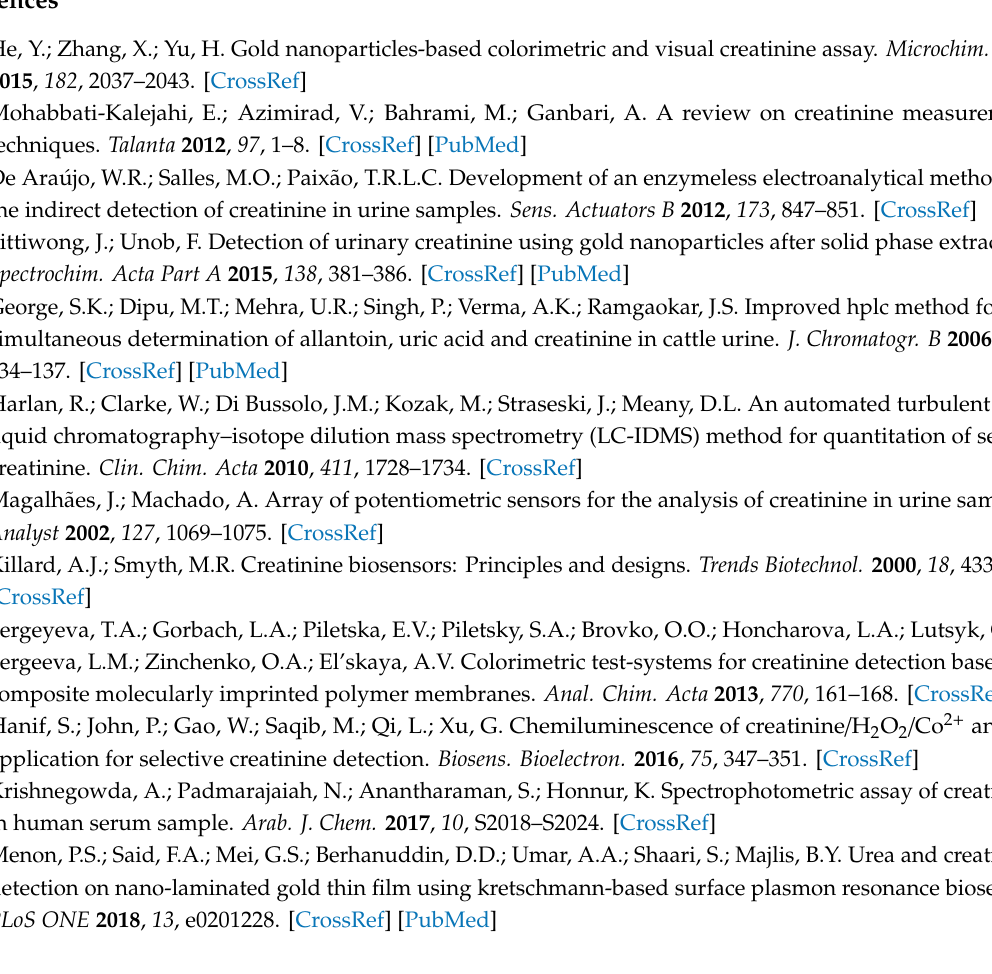
Figure S1: The stability of the PEG / Hg2 + –AuNP probe: Photographs and UV–Vis absorption spectra of the above sensor after being placed for 72 h, Figure S2: DLS diagram of images of PEG / Hg2 + –AuNPs system in the (a) absence and (b) presence of creatinine, Figure S3: XPS spectra of PEG / Hg2 + –AuNPs in the presence of creatinine with binding energies for (a) N1s, and (b) Hg4f, Figure S4: The role of Hg2 + : Absorption spectra of samples using di ff erent kinds to replace Hg2 + , Figure S5: Sensitivity of the AuNP probe (0.798 nM) in urine simulating fluid sample: (A) Photographs and (B) absorption spectra of serum samples containing di ff erent concentration of creatinine (from 20 to 120 µ M), inset: (C) linear relationship between creatinine concentration and absorbance response di ff erence in urine simulating fluid sample, Figure S6: Practicability of AuNPs probe (0.798 nM) in real bovine serum samples: (A) Photographs and (B) absorption spectra of real bovine serum sample containing di ff erent concentrations of creatinine (from 20 to 50 µ M), inset: linear relationship between creatinine concentration and absorbance response in bovine sample, Figure S7: Linear relationship of creatinine content with A500 nm values by Ja ff e’s method for bovine serum sample, Table S1: The comparison of TEM and DLS data before and after detection, Table S2: Atomic content of PEG / Hg2 + –AuNPs before and after detecting creatinine, Table S3: The comparison of this PEG / Hg2 + –AuNP with some reported methods, Table S4 Determination of creatinine by proposed sensor and Ja ff e’s